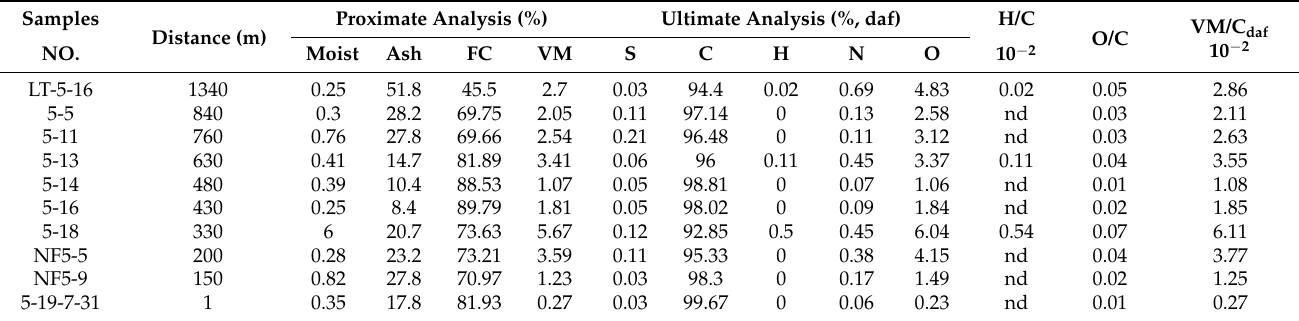
Table 1. Proximate and ultimate analysis of